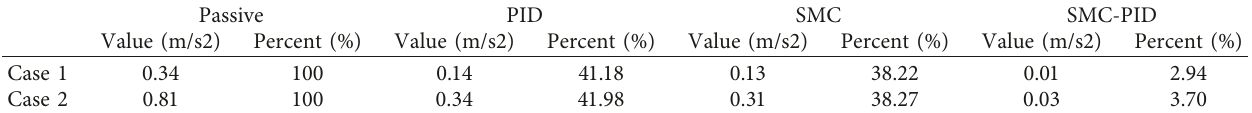
Table 5: The average acceleration of the sprung